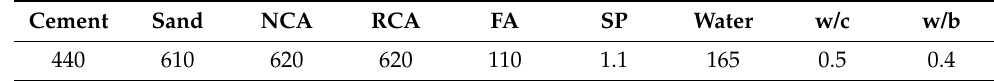
Table 1. Mix properties of concrete (kg · m − 3 ).